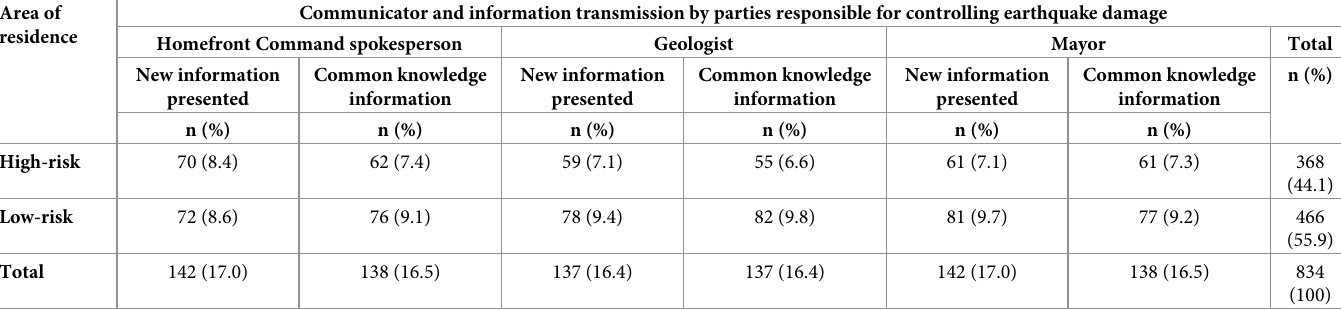
n (%)New information